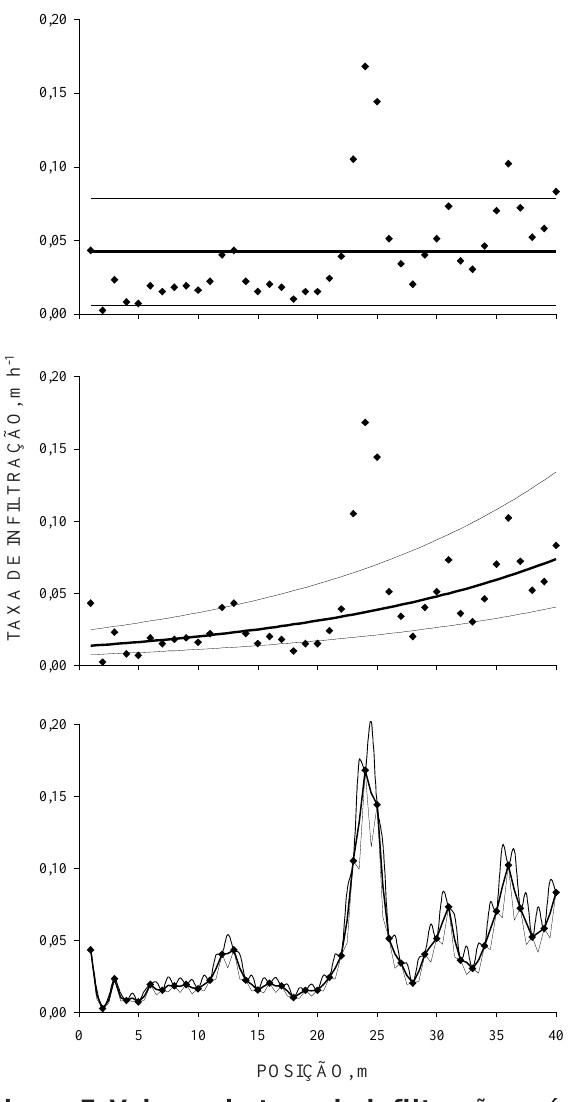
Figura 7. Valores da taxa de infiltração após 105 min, mostrando a descrição desta propriedade (linha grossa) com seus respectivos desvios (linha fina): (a) estatística clássica, apenas média; (b), estatística clássica com regressão dos dados transformados e (c) geoestatística, regressão e krigagem dos dados transformados. Os pontos representam os valores